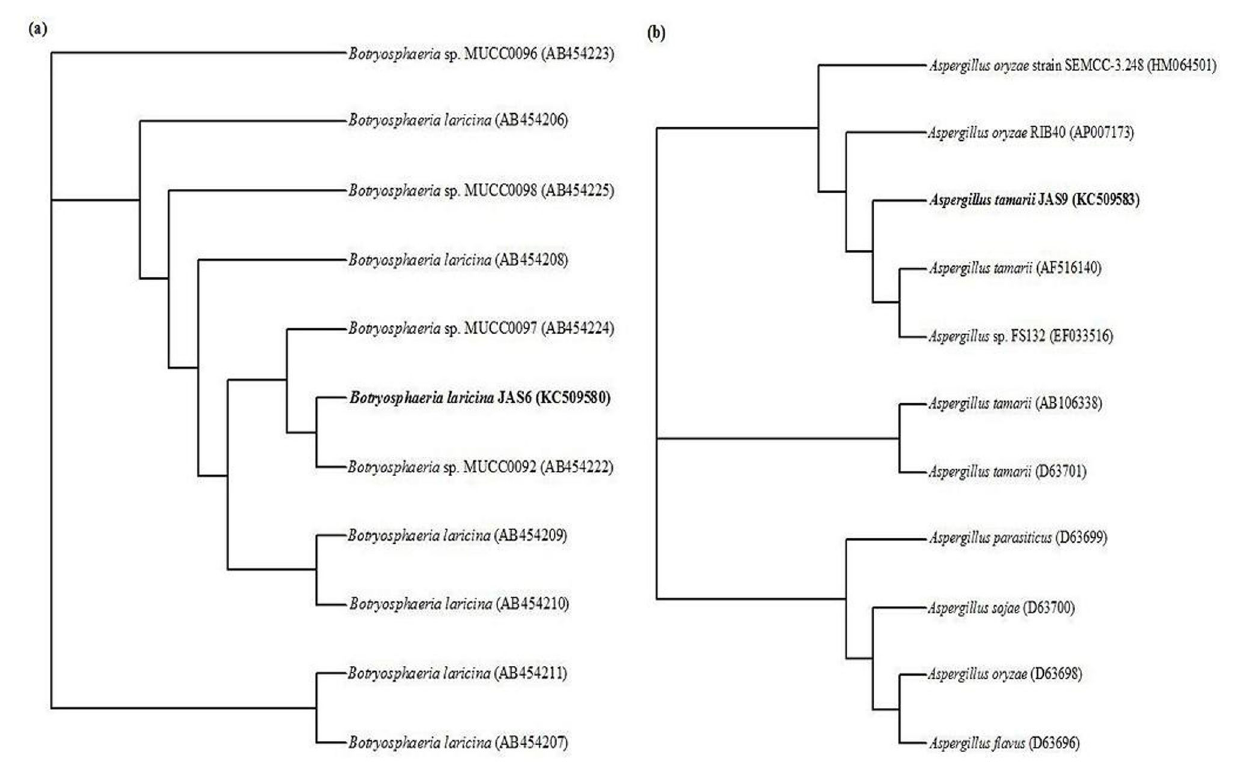
Figure 1. Phylogenetic analysis of 18S rRNA gene sequences (a) between Botryosphaeria laricina JAS6 and reference sequences; (b) Aspergillus tamarii JAS9 and reference sequences retrieved from NCBI GenBank constructed through neighbor joining